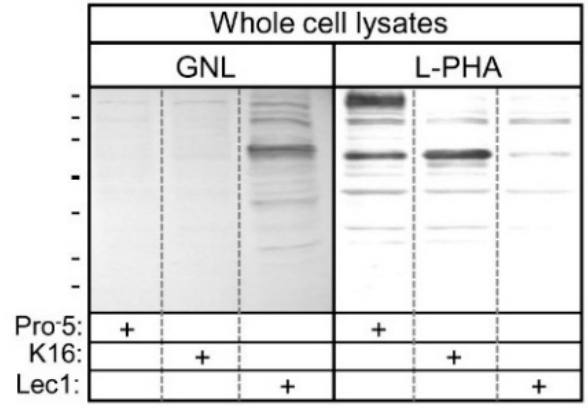
Figure 2. Cont. Figure 2.